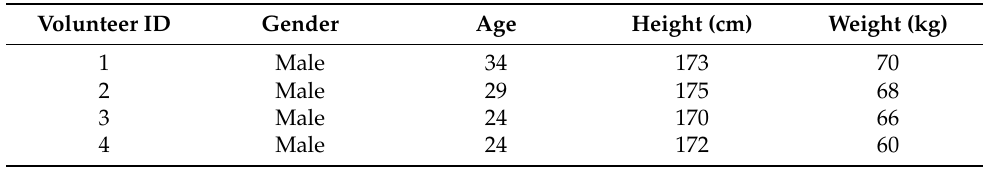
Table 1. The basic information of the